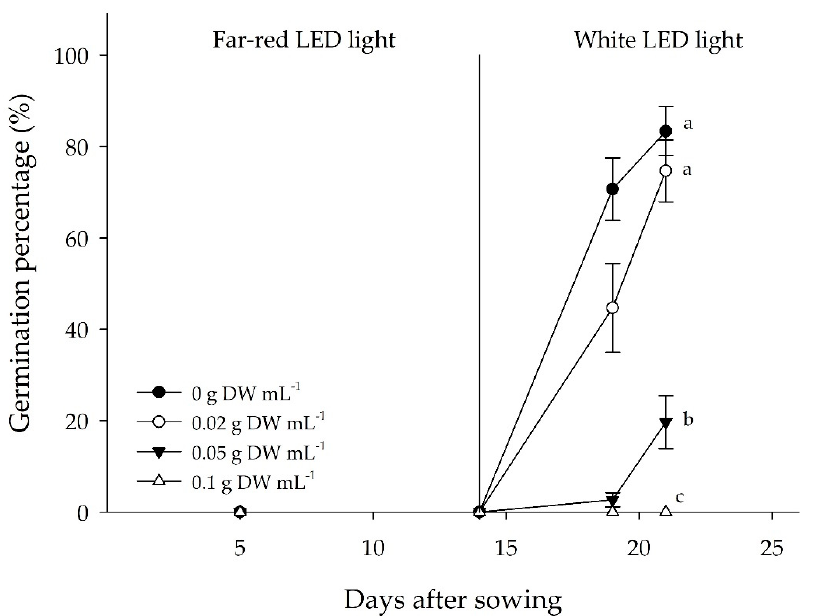
Figure 3. Germination percentage (%) of Cobbler’s pegs seeds that incubated in di ff erent concentrations of residue extract under FR (LED, 730 nm, 0.71 µ mol m − 2 s − 1 , 12-h photoperiod, FR L treatment of the laboratory experiment) for 14 days and then changed the light source to white light (LED, 400–750 nm, 6500 k, 149 µ mol m − 2 s − 1 , 12-h photoperiod) for the next 7 days. The R / FR of white LED and far-red LED light were 11 and 0.01, respectively. Seeds incubated in the concentration of 0.1 g DW mL − 1 were not germinated until the end of the experiment. Error bars are the standard error ( n = 5). The same letters indicate no significant di ff erence at p < 0.05 by Fisher’s protected LSD